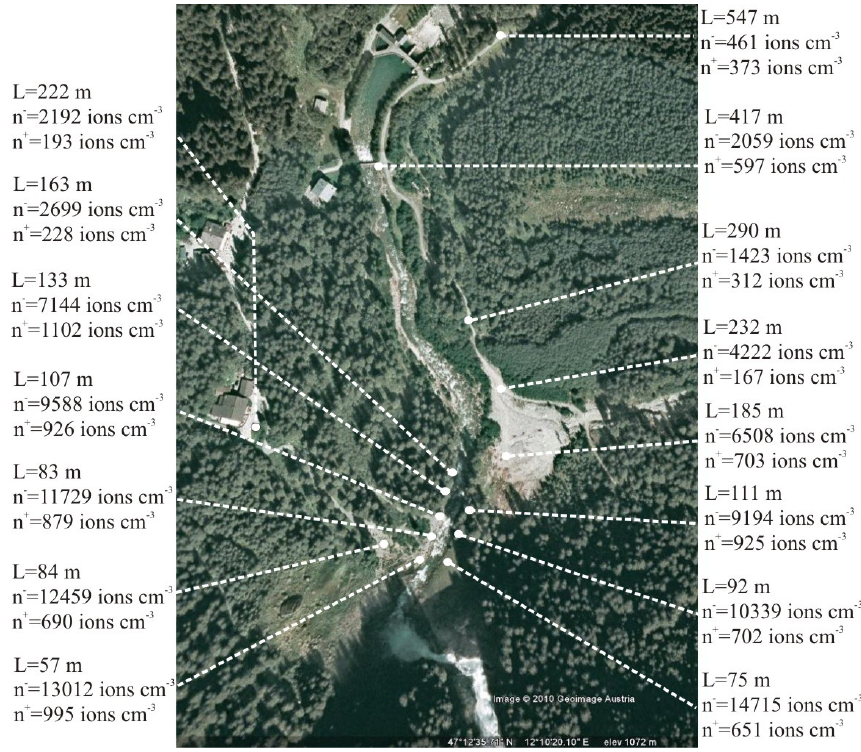
Fig. 6. Average concentrations of ions ≤ 2nm measured in the summer period from 2008 to 2010. on both sides of the Krimml WF. The distances from the WF were measured via GPS and visualized on a Google Earth